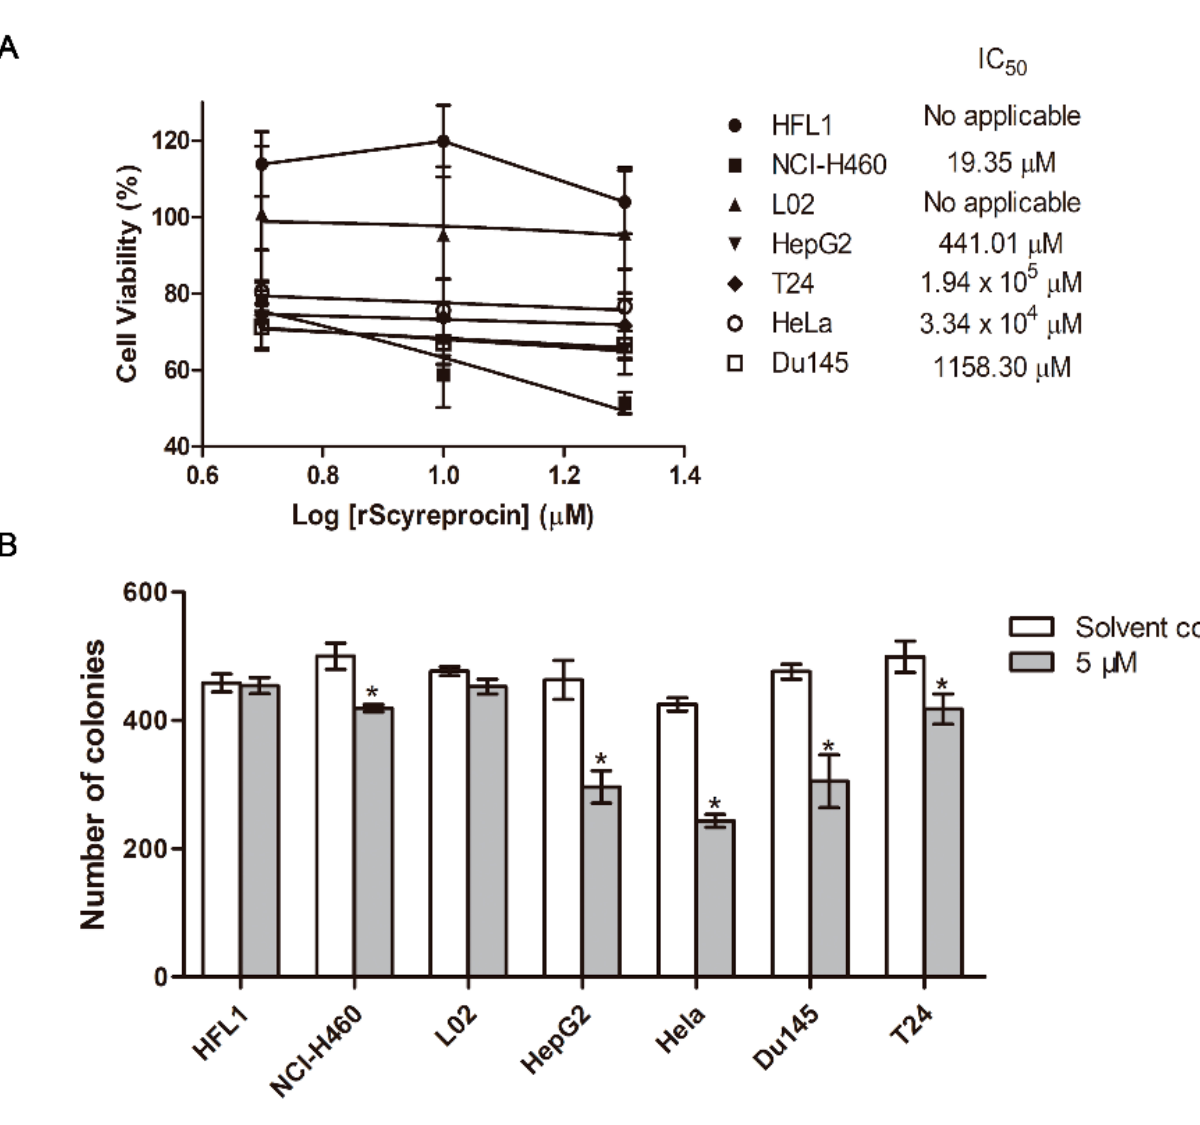
Figure 1. Anticancer activity of recombinant scyreprocin (rScyreprocin). ( A ) Effect of rScyreprocin on cell viability. Cells were incubated with various concentrations of rScyreprocin for 24 h; the cell viability was assessed by MTS method ( n = 3). ( B ) Effect of rScyreprocin on colony formation ability. Cells were incubated with 5 µ M rScyreprocin for 48 h and grown in rScyreprocin-free culture medium for another 12 days; colonies that contained > 50 cells were then counted and analyzed ( n = 3). Data in ( A , B ) are presented as means ± standard deviations (SD). * p < 0.05 (two-way ANOVA, Bonferroni